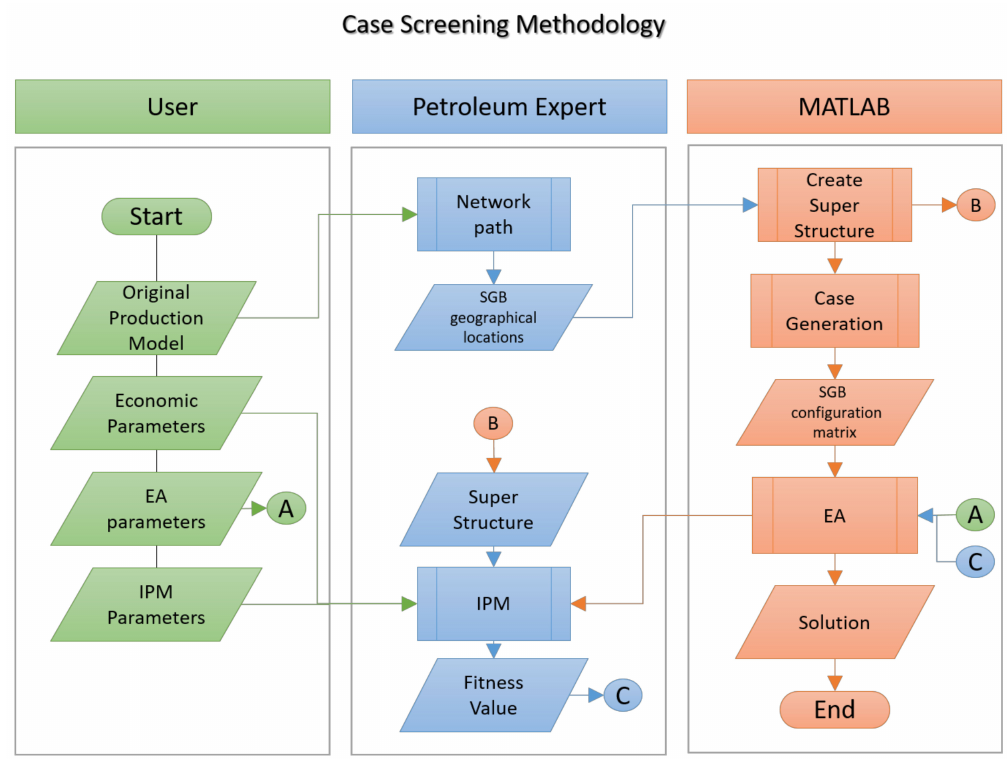
Figure 3. Flow diagram of the case generation and scenario screening methodology. EA: evolutionary algorithms and IPM: integrated production